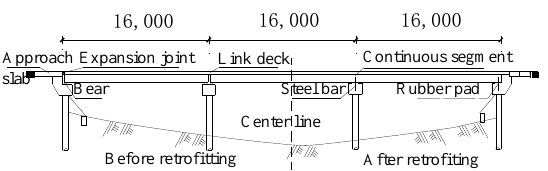
Figure 2. Elevation of the Jingpu Bridge before and after retrofitting.